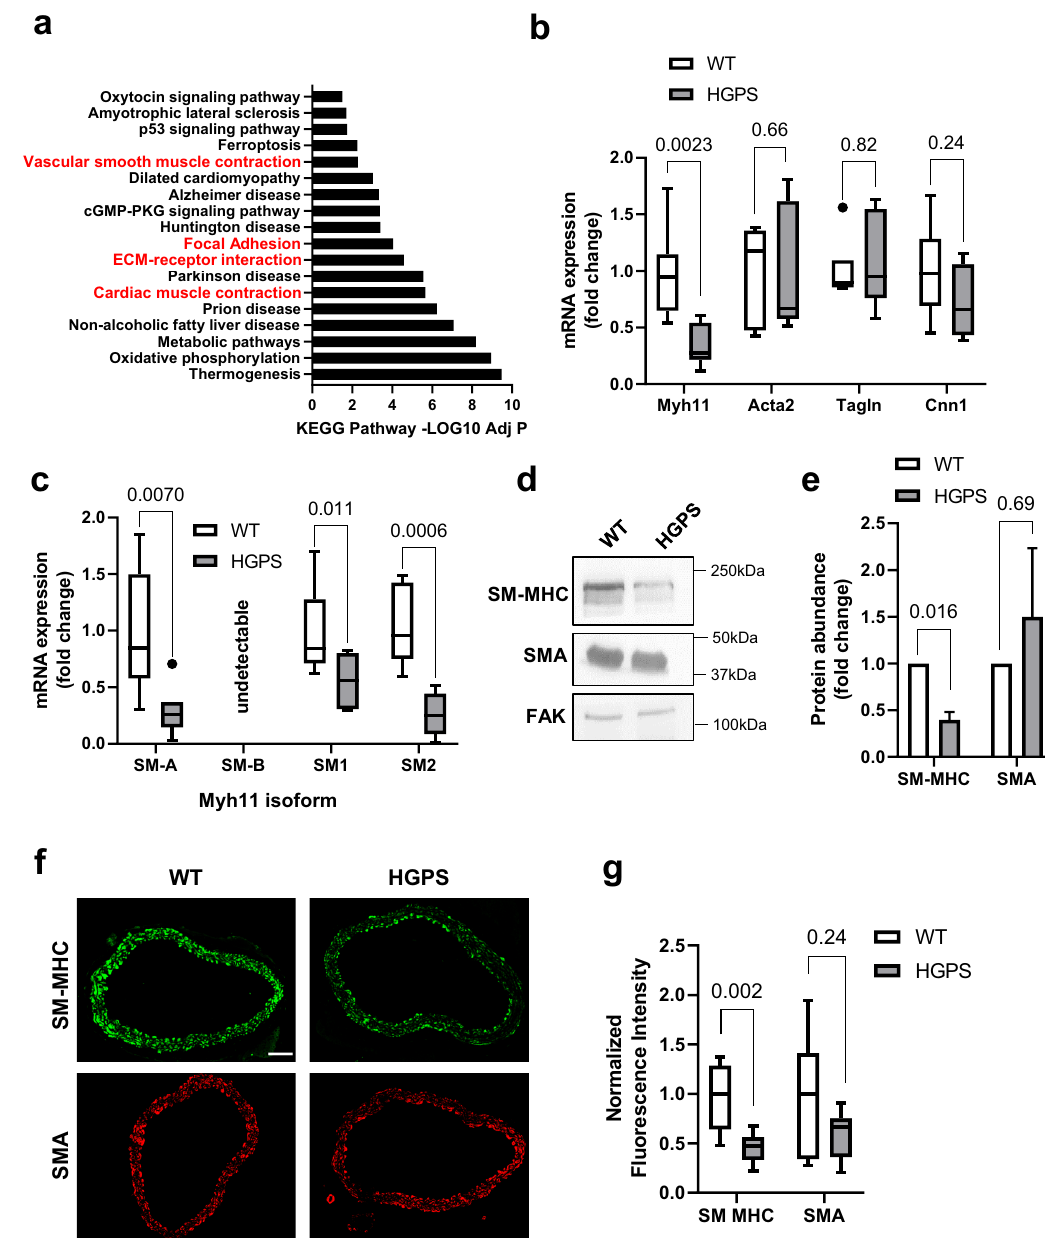
Figure 1. Reduced smooth muscle myosin heavy chain abundance in HGPS aortas. ( a ) KEGG pathway analysis was performed on the differentially expressed genes from 2-month WT versus HGPS descending aortas (n = 6 per genotype). KEGG pathways with p-adjusted values < 0.05 are shown. ( b ) Descending aortas were isolated from 2-month WT and HGPS mice (n = 5–7 per genotype). SMC contractility gene transcript levels were assessed by RT-qPCR and plotted relative to the WT control. ( c ) Smooth muscle myosin heavy chain isoform transcript expression was assessed by RT-qPCR in 2-month WT and HGPS descending aortas (n = 7 per genotype) and plotted relative to the WT control. ( d ) Representative images of SM-MHC and SMA protein levels determined from 2-month WT and HGPS descending aortas by immunoblotting. Focal Adhesion Kinase (FAK) is shown as the loading control. Black boxes around the immunoblots indicate cropping for removal of extraneous space. Unprocessed blots are shown in Fig. S1. ( e ) Quantification of immunoblotting results normalized for loading and plotted relative to the WT control. Results show mean ± SE (n = 7 per genotype). ( f ) Representative images of 2-month WT (n = 7) and HGPS (n = 9) descending aorta cross sections immunostained for SM-MHC and SMA; scale bar = 50 µm. ( g ) Quantification of aortic immunostaining with results plotted relative to the WT controls. Results in b, c and g are shown as box plots with Tukey whiskers, and significance was determined by Mann–Whitney tests. Significance in panel e was determined by Wilcoxon signed rank test and data is displayed as mean ±